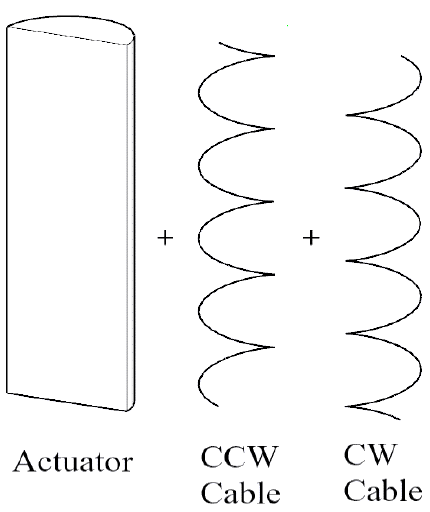
Figure 3. Extension design of soft pneumatic actuator.